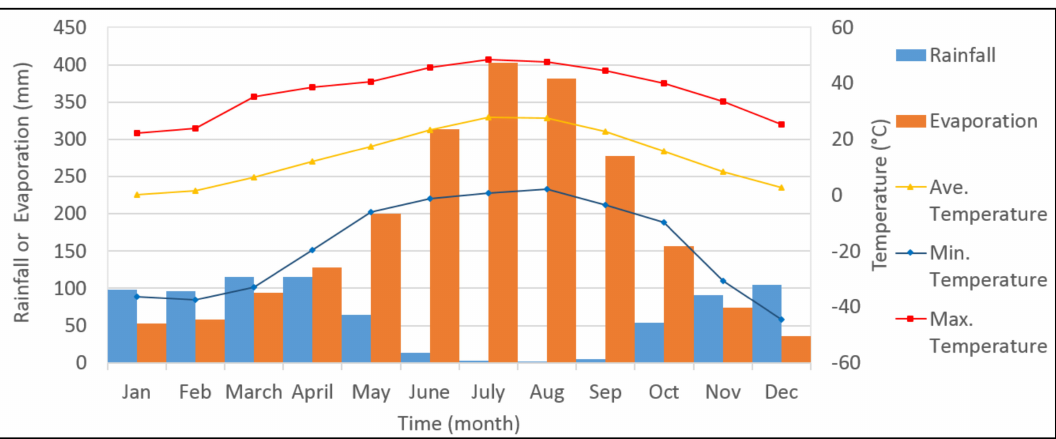
Figure 3. Average monthly precipitation, evaporation, minimum temperature, maximum temperature, and average temperature. We used 96, 15, and 21 meteorological stations for the average calculation of precipitation, evaporation, and temperature for the whole basin area,